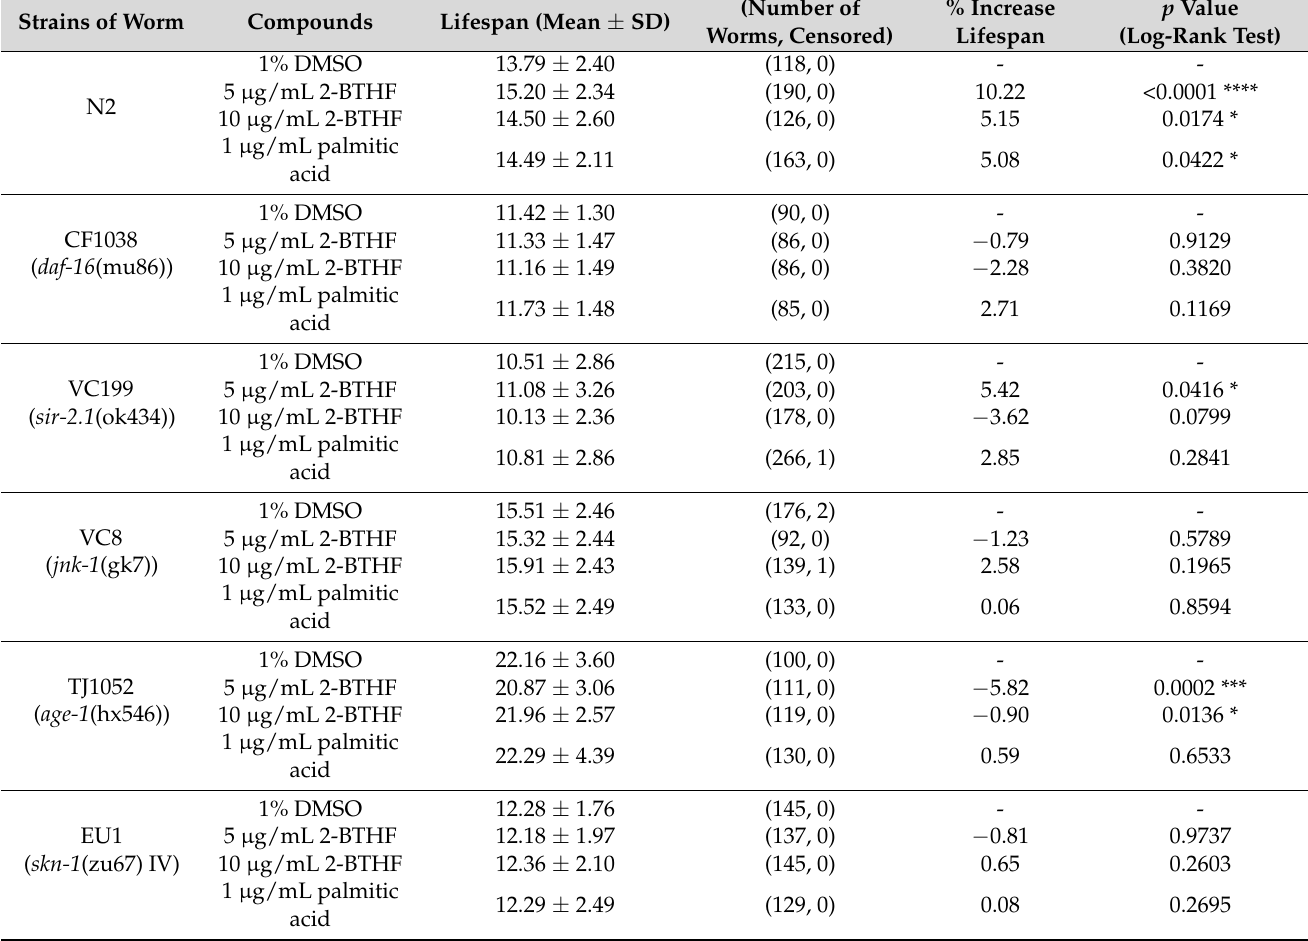
Table 2. Effects of purified H. scabra compounds on mean lifespans of wild type N2 and mutant worms at 22 ◦